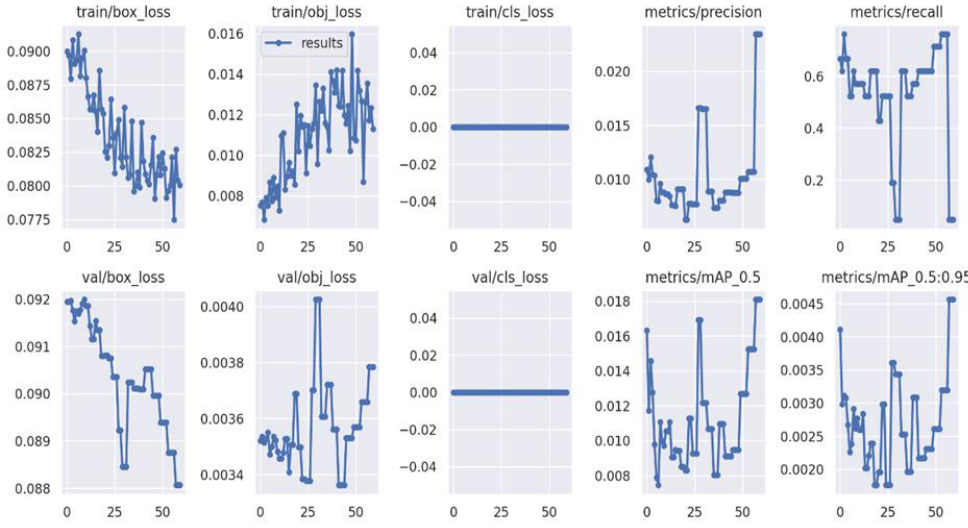
Figure 7. Overall performance